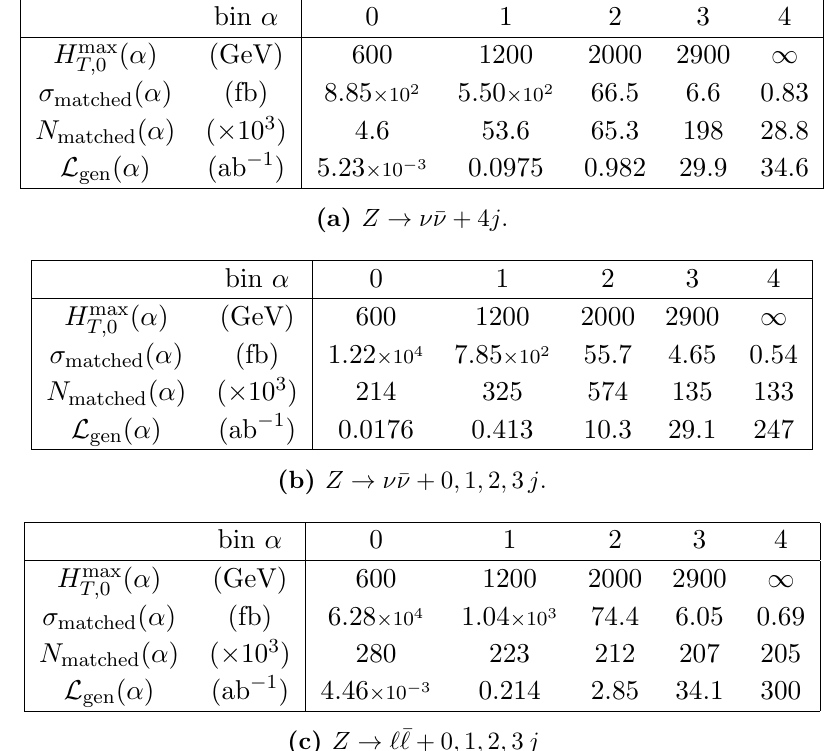
max ( (cid:11) ), the leading-order matched cross section, (cid:27) matched , 0 , H T; 0